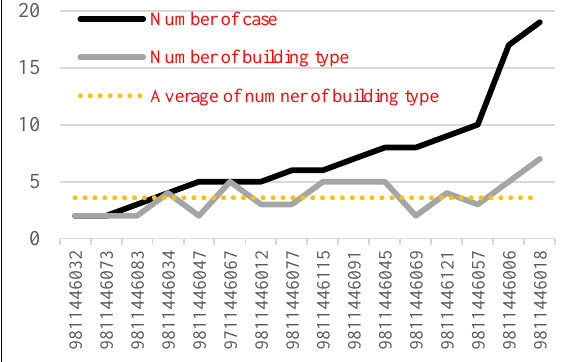
Figure 10. Building type and amount data shared by participants